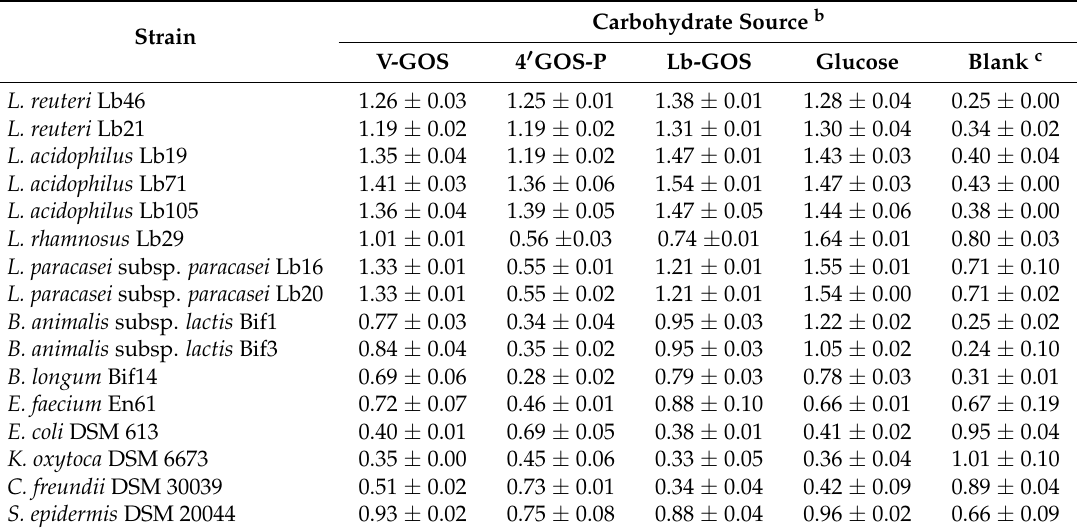
Table 2. Maximum optical densities OD 600 a of single-culture fermentations using different galacto- oligosaccharide mixtures or glucose as the main carbohydrate